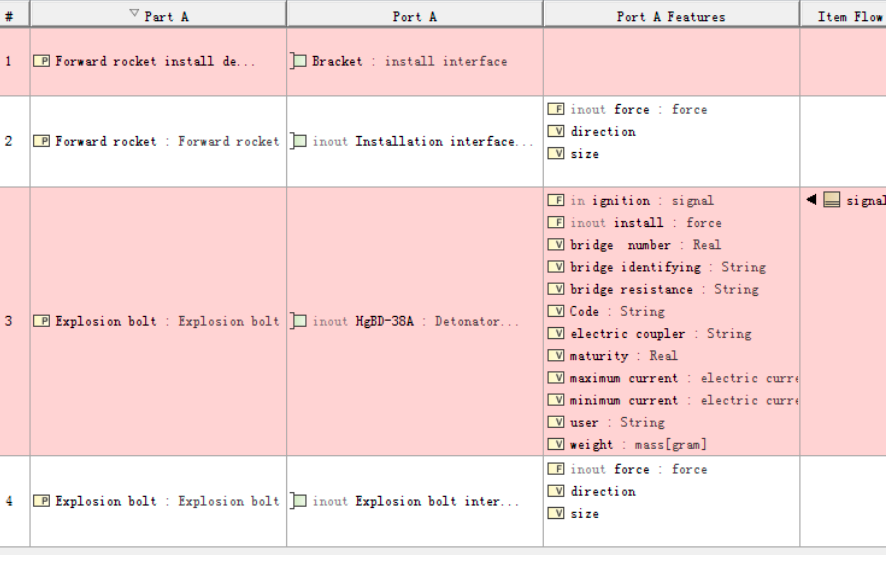
Figure 14. Interface control documents.